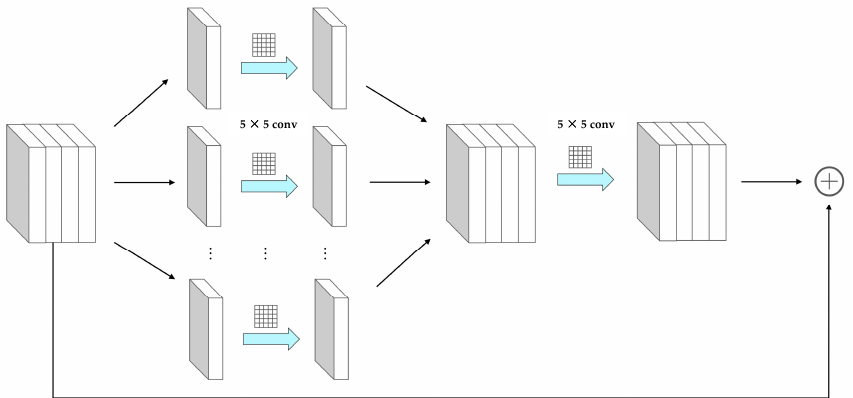
Figure 4. The illustration of the residual block based on group